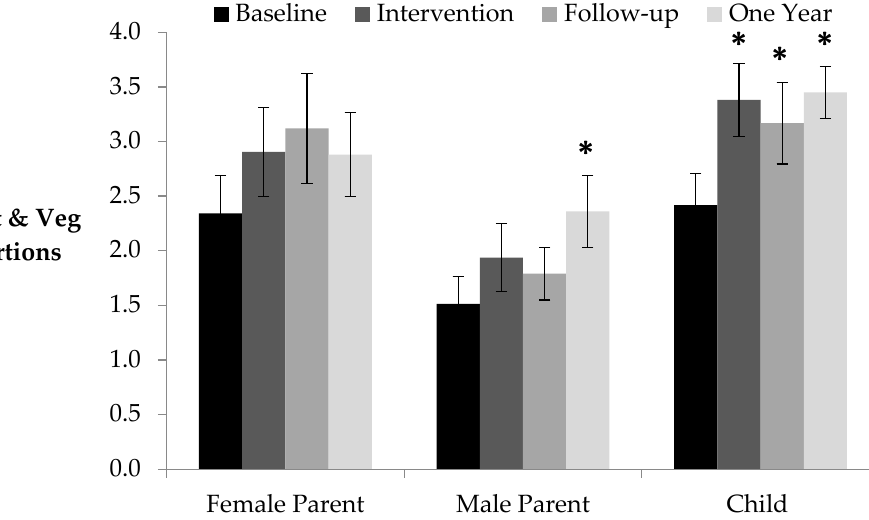
Figure 2. Fruit and vegetable consumption portions (80 g) per day (se) average per person, and the family as a whole as average per family member (se) at each two-week stage (* p < 0.05 Bonferroni corrected relative to